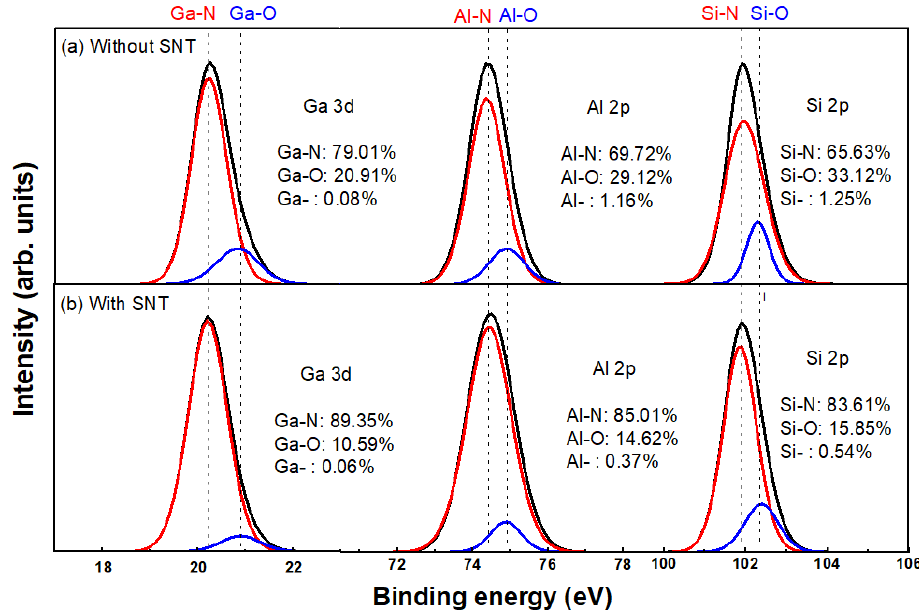
Figure 7. Ga 3d (left), Al 2p (middle) and Si 2p (right) core-level spectra at the Si 3 N 4 /AlGaN interface in the 8-nm Si 3 N 4 /AlGaN/GaN samples ( a ) without SNT and ( b ) with SNT. Each measured spectrum (symbol) is resolved into two Gaussian functions that correspond to M in M-N (solid red line) and M-O (solid blue line) bonds. M represents Ga ( left ), Al ( middle ) or Si ( right ). The solid blue red line is a superposition of the two fitting